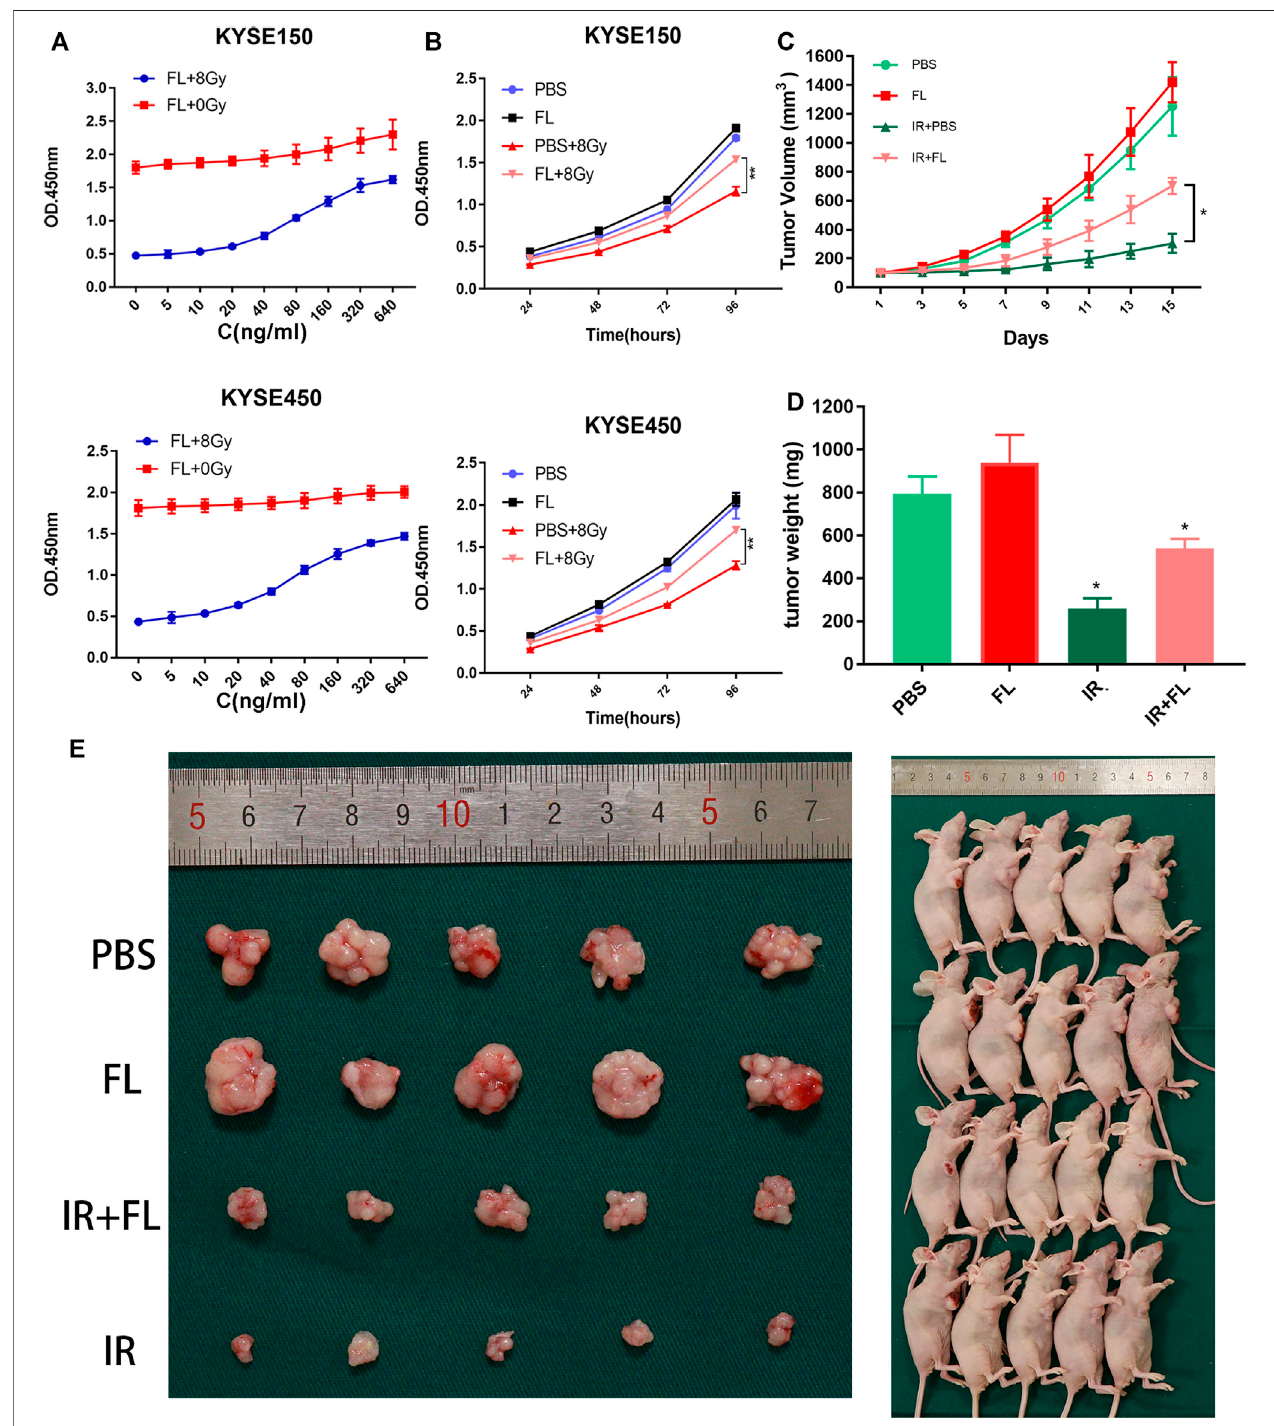
FIGURE 1 | FL promotes viability and tumor growth of ESCCs in vitro and in vivo . (A) The cell viability of ESCC cells in different concentration (0, 5, 10, 20, 40, 80, 160,320,and640 ng/ml)ofFL(n (cid:2) 3). (B) Cellviabilityofdifferenttime-pointafter200 ng/mlFLtreatment(n (cid:2) 3). (C) Thetumorvolumeassessedevery2days(n (cid:2) 5). (D) The tumor weight after sacri fi ced (n (cid:2) 5). (E) Images of nude mice (n (cid:2) 5). Mean ± SEM, * p < 0.05, ** p < 0 0.01.